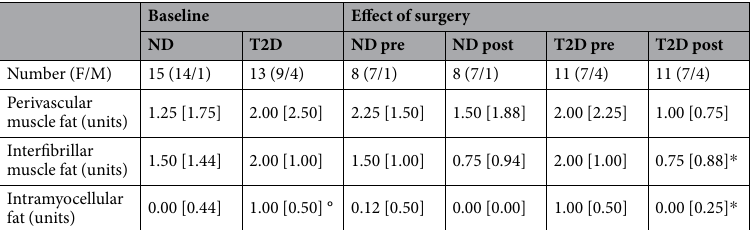
Table 2. Changes in muscle histology (semi-quantitative analyses) § . § entries are median [interquartile range]. °p ≤ 0.01 T2D vs ND by Mann Whitney test. * p ≤ 0.05 for the changes at 1 year vs baseline by Wilcoxon sign rank